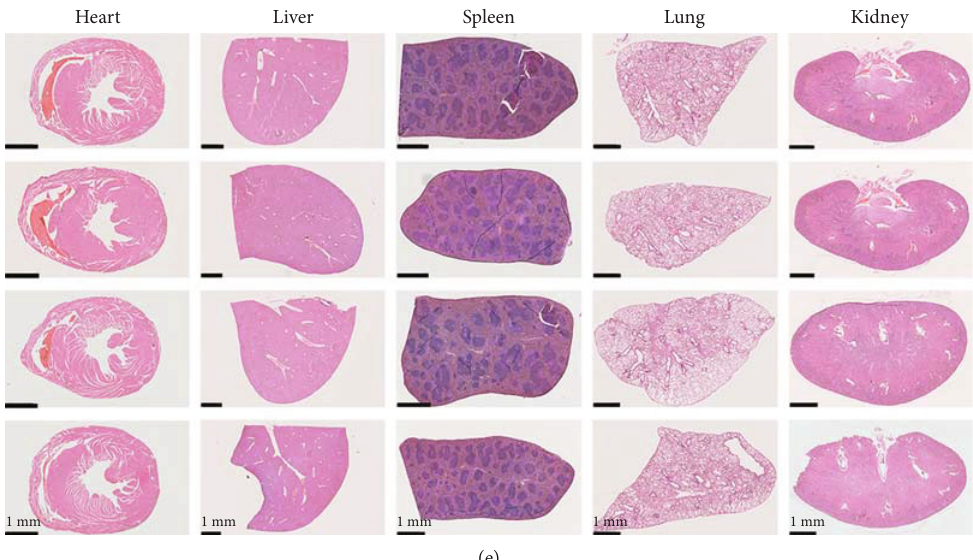
Figure 3: UCMSC-AAM transplantation promotes endometrial thickness, mRNA and protein expression, and regulates in fl ammation factors of injured endometrium. (a) Hematoxylin and eosin (H&E) staining of uterine in the injury group, the AAM group, the UCMSC- AAM group, and the normal group. Scale bars, 500 μ m, 25 μ m, and 50 μ m. The black arrows indicate epithelial cells, and the red arrows indicate glands. Each experiment was repeated four times. Statistical analysis of the endometrial thickness measured by Image-Pro Plus 6.0 software. ∗ P < 0 : 05 , ∗∗ P < 0 : 01 , ∗∗∗ P < 0 : 001 . (b) Immunohistochemical staining of keratin, vimentin, and integrin β 3 for epithelial cells, stromal cells, and endometrial receptivity in endometrium of the injury group, the AAM group, the UCMSC-AAM group, and the normal group. Scale bars, 100 μ m. Statistical analysis of IOD (Integral optical density) value of positive areas measured by Image-Pro Plus 6.0 software. ∗ P < 0 : 05 , ∗∗ P < 0 : 01 , ∗∗∗ P < 0 : 001 . (c) Relative mRNA expressions of keratin, vimentin, and integrin β 3 in endometrium tissues of rats in the injury group, the AAM group, the UCMSC-AAM group, and the normal group that were compared. The relative expression